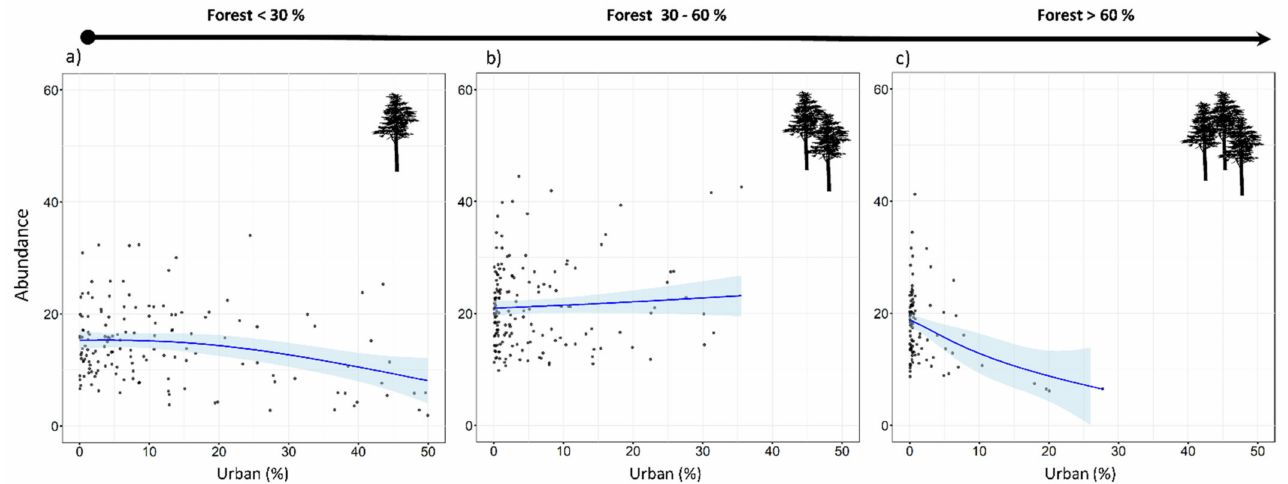
Figure 3. Expected tawny owl ( Strix aluco ) abundance at the local scale and based on the top-ranked model in three forest levels ( a – c ) along an urban gradient. The blue lines show a cubic smoothing spline fitted to the data to show the general trend, while shaded areas show standard error